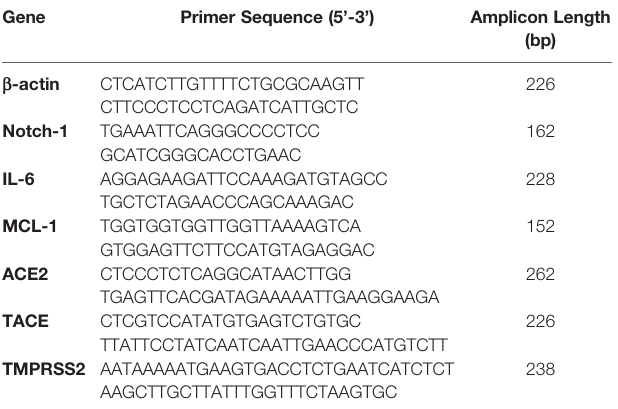
TABLE 1 | Primer sequences of genes used in this